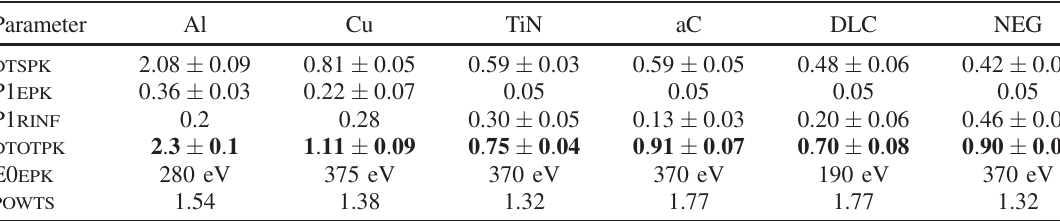
TABLE VII. Best fit SEY parameters. Error bars are given for the parameters used in the fit. Values without error bars were either assumed, or taken from in-situ SEY measurements (see Sec. III A). Note that DTOTPK is the sum of the three SEY components at peak energy.